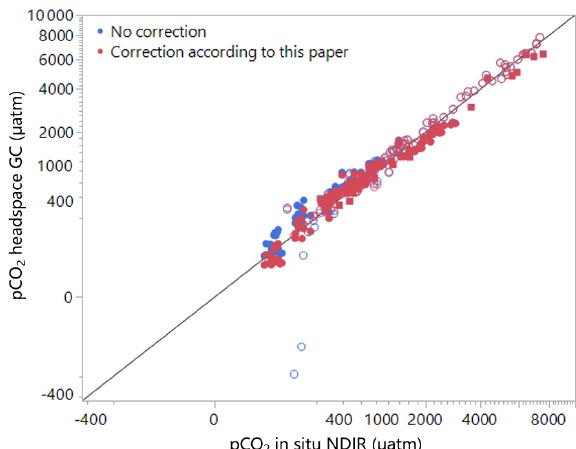
Figure 4. Comparison of uncorrected and corrected data with direct p CO 2 measurements by NDIR analysis. Note the cube-root scale in both axes. Open-circle symbols: ambient-air headspace; closed- circle symbols: CO 2 -free gas headspace; and closed-square sym- bols: pre-measured-CO 2 gas (between 150 to 250ppm) headspace